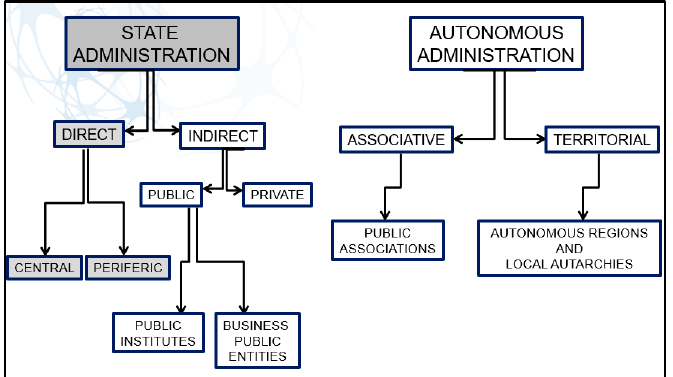
Figure 2. Adapted from Amaral